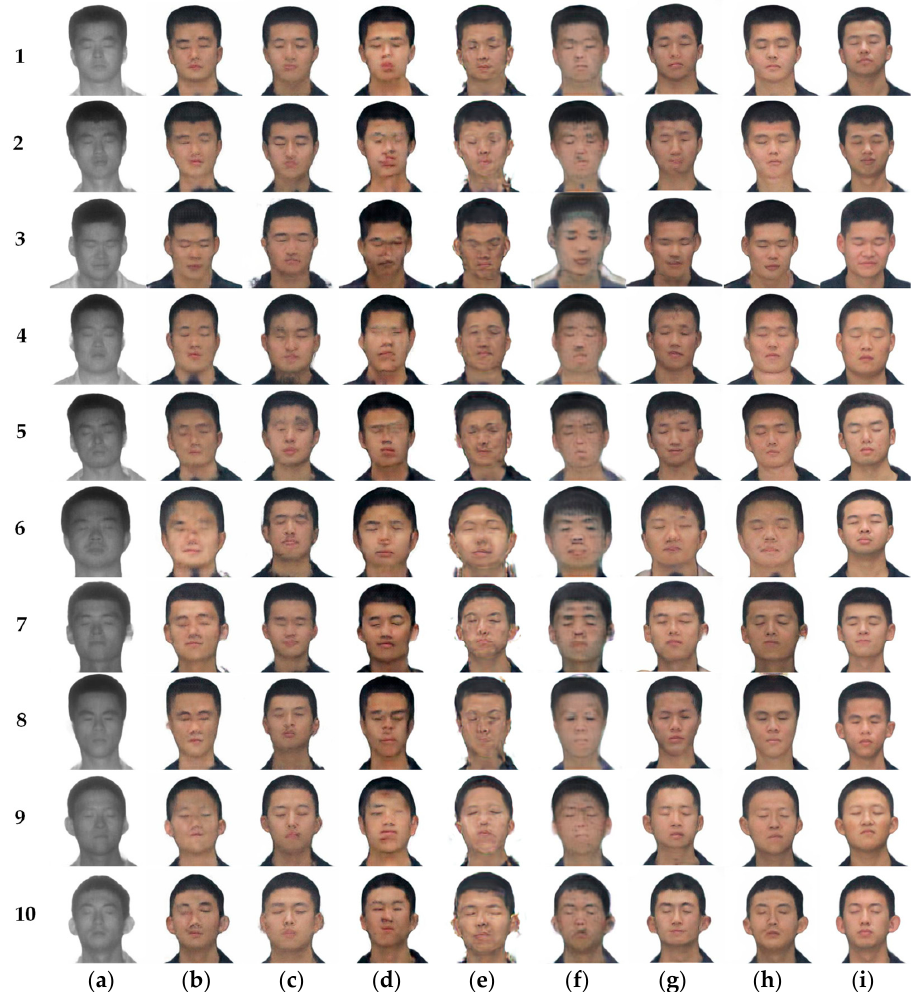
Figure 11. Different methods for Laser-visible facial image translation. ( a ) Laser image. ( b ) Cy- cleGAN. ( c ) Pix2Pix. ( d ) UNIT. ( e ) UGATIT. ( f ) StarGAN. ( g ) DCLGAN. ( h ) Ours (SN-CycleGAN). ( i ) Ground truth.